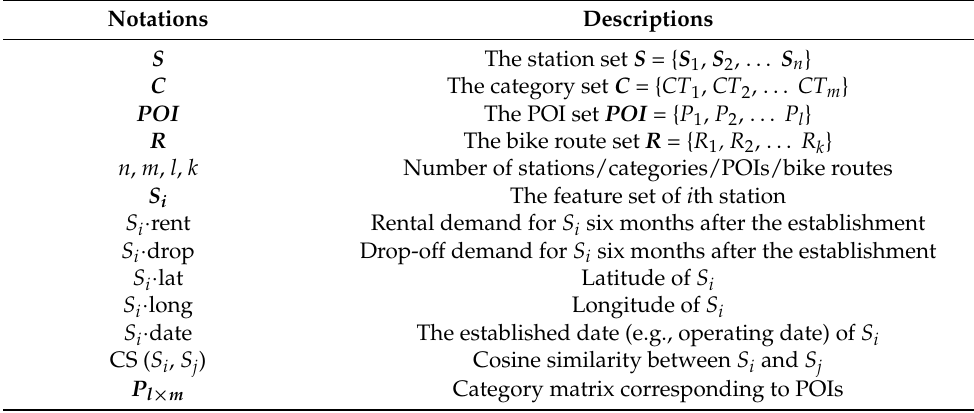
Table 1. Notations used in this paper.